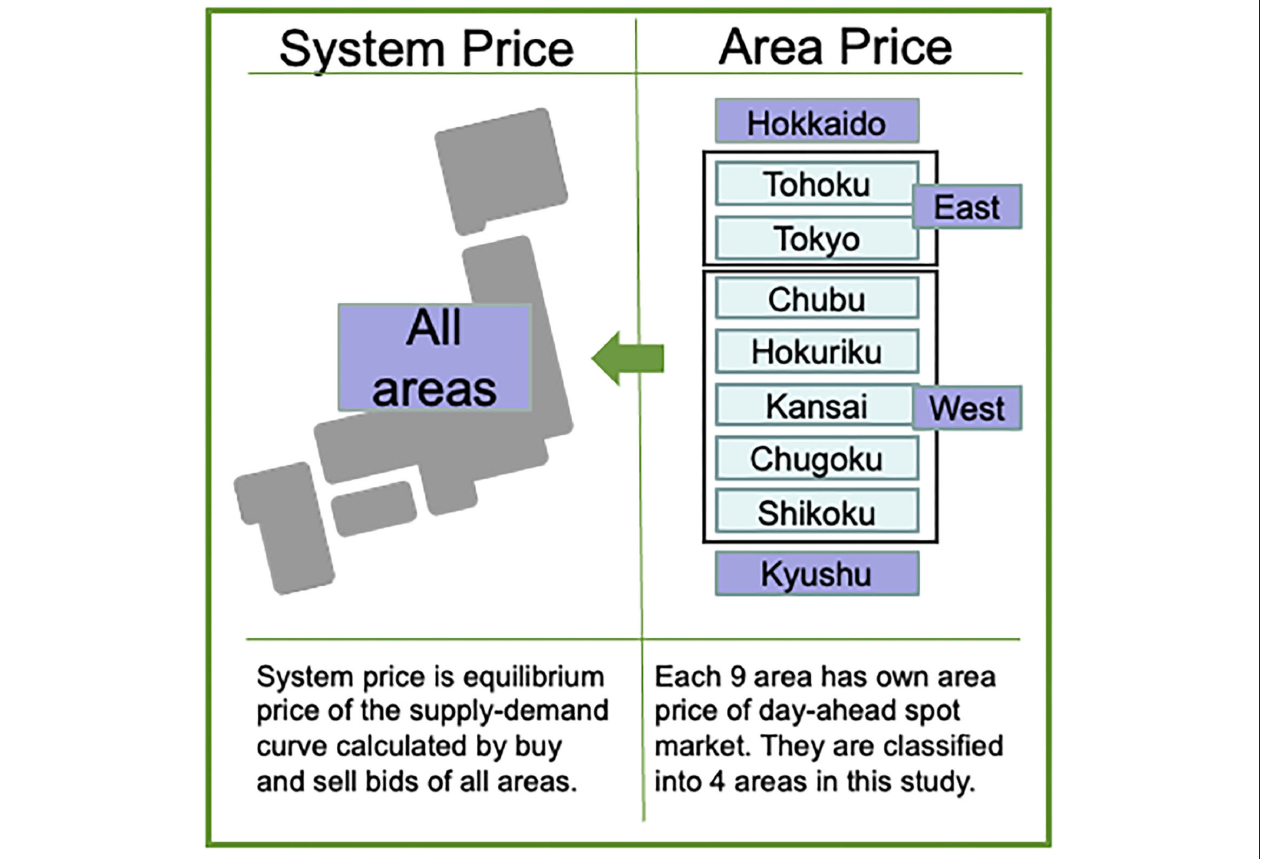
FIGURE 2 | Classification of the four areas. (Source: created by authors).